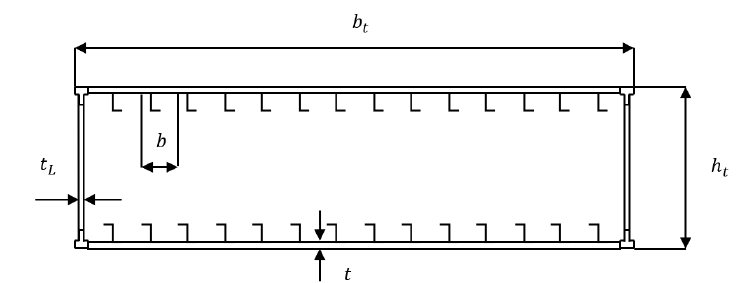
Figure 2. Torsion box drawing, where height is h t , length is b t , spar web thickness is t L and pitch between stringers is b